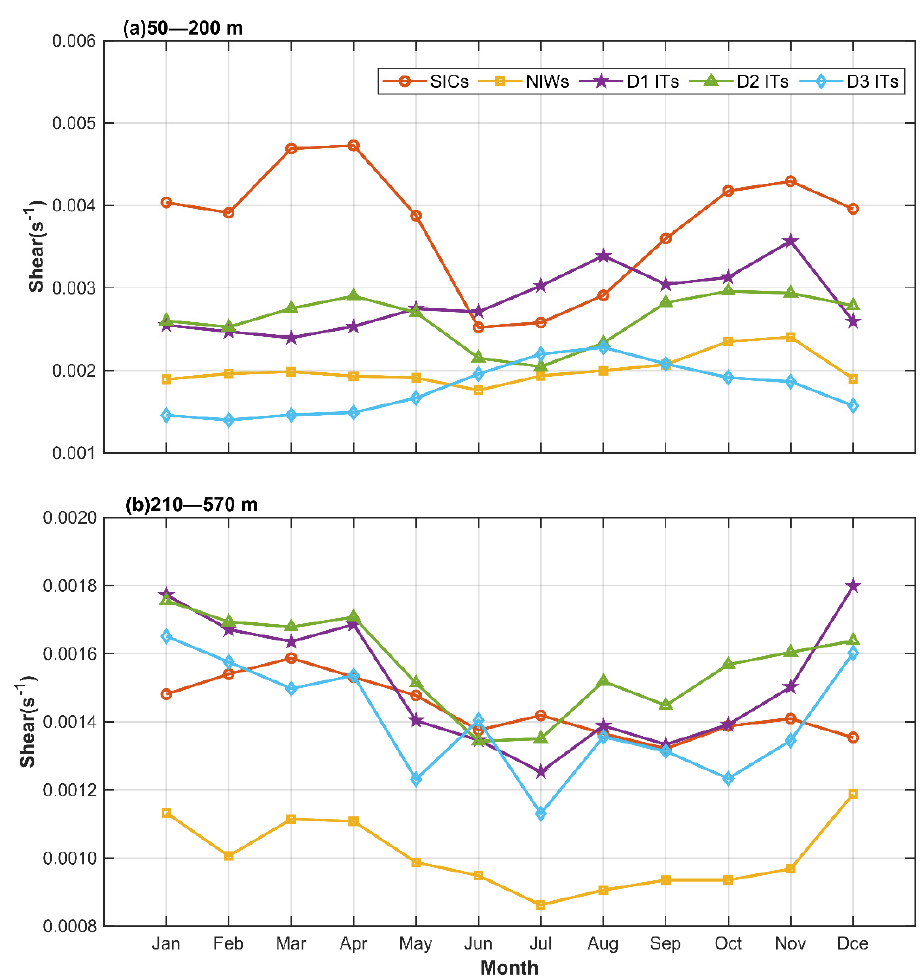
Figure 6. Seasonal evolutions of the depth-averaged shear caused by SICs (orange), NIWs (yellow) and D1 (purple), D2 (green), and D3 (light blue) ITs. ( a , b ) represent the shear averaged over 50–200 m and 210–570 m, respectively.